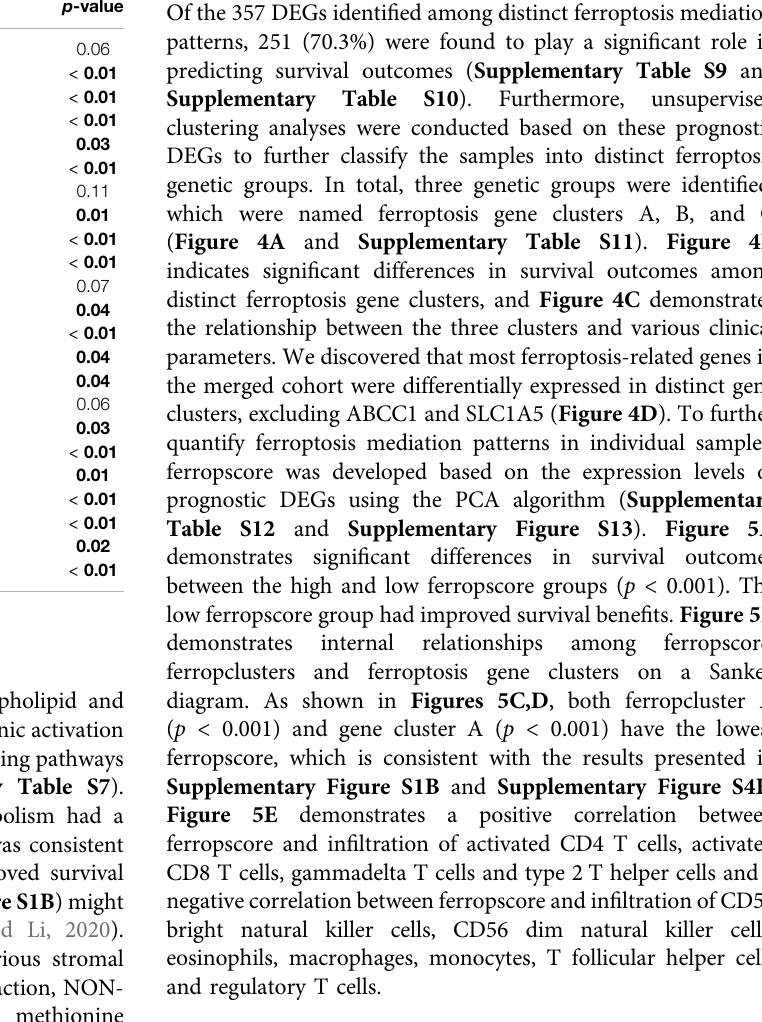
TABLE 1 | Prognostic analysis of ferroptosis-related genes for survival outcomes in merged cohort. Gene